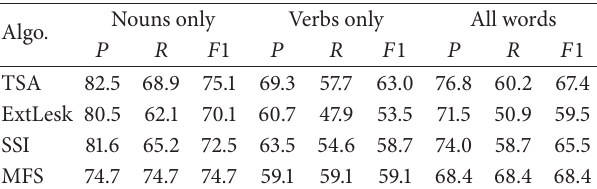
Table 2: The performance of disambiguating through TSA versus other state-of-the art